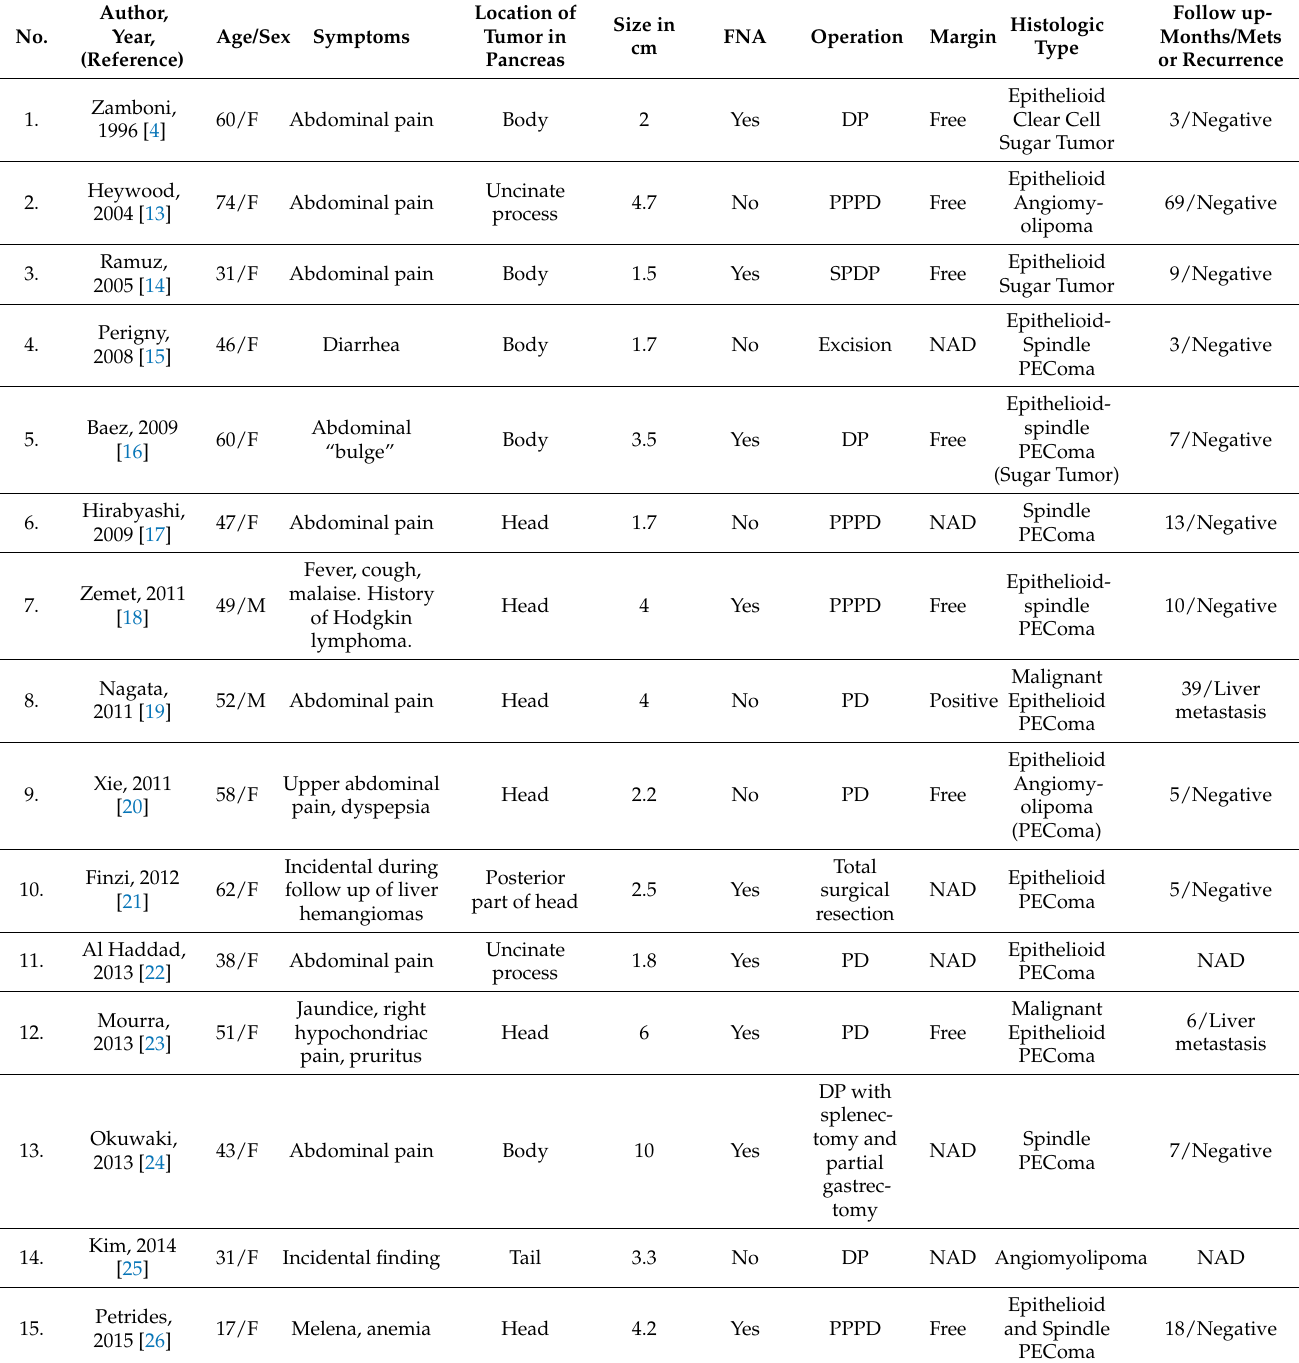
Table 1. Reported Cases of PEComa of the Pancreas